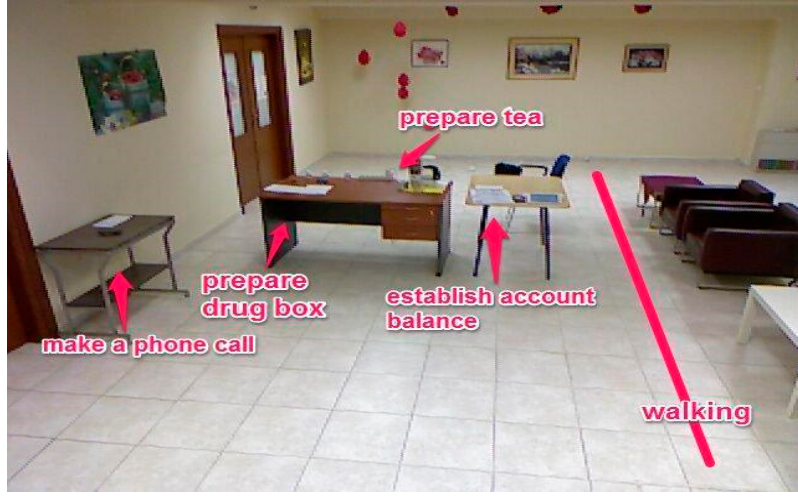
Figure 1. Thessaloniki short protocol installation.